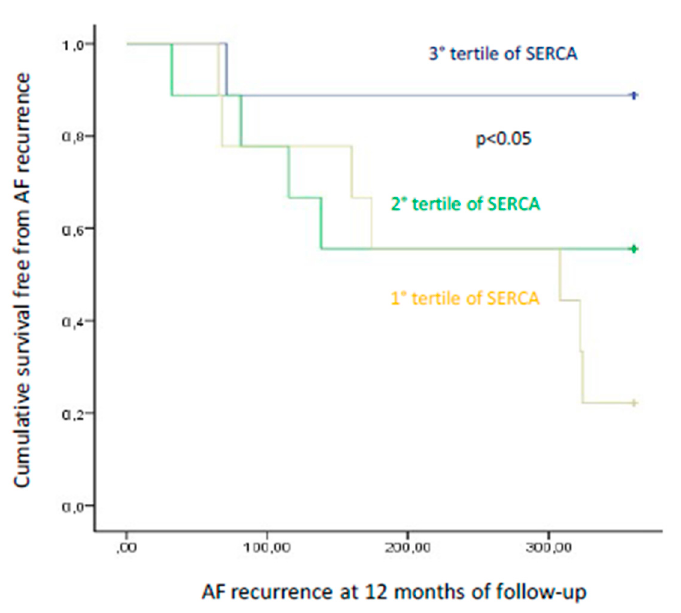
Figure 3. Kaplan curve for cumulative survival free from atrial fibrillation (AF) events dividing study population into tertiles of sarcoplasmic endoplasmic reticulum calcium ATPase (SERCA) values. Yellow: 1° tertile; green: 2° tertile; blue: 3° tertile. We used a log-rank test for the equality of survival distributions for the different levels and tertiles of SERCA, with Χ 2 = 6.241 and p < 0.05 considered as statistically significant.